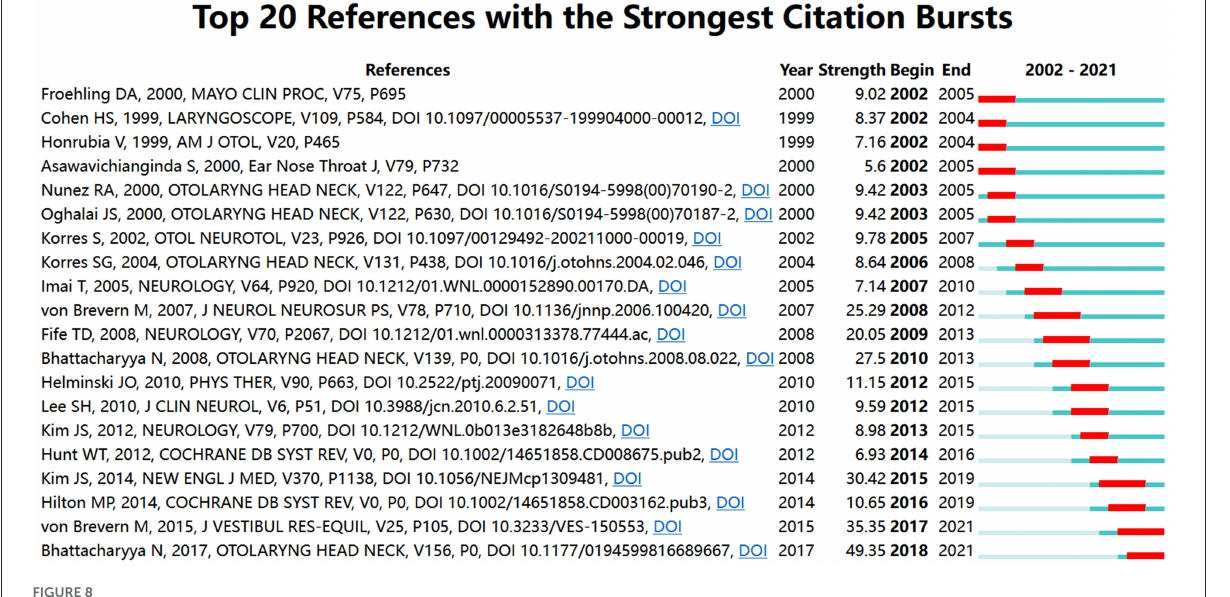
FIGURE8 The top-20 references with the largest citation bursts (2002–2021).